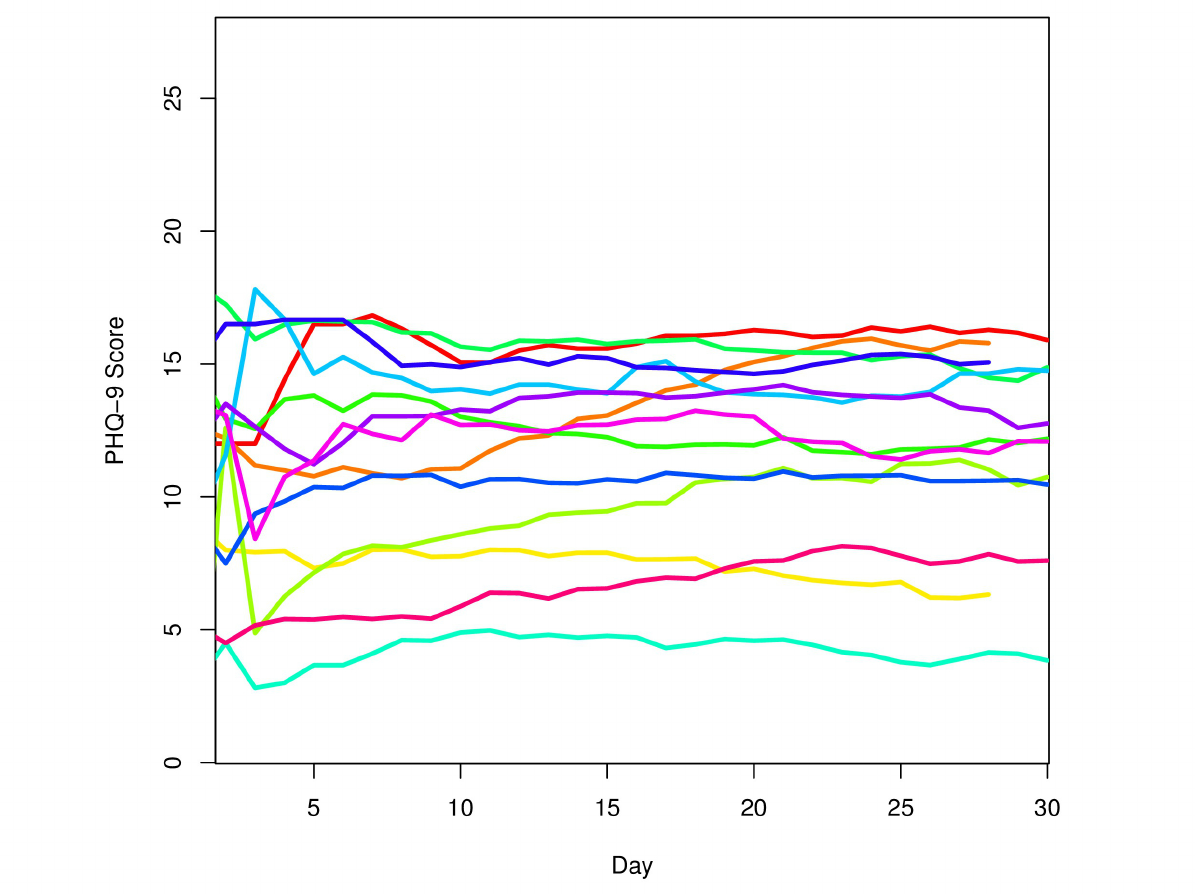
Figure 5. A composite plot of daily PHQ-9 score predictions. As weighted averages of recent scores, these predictions are much smoother than the estimates